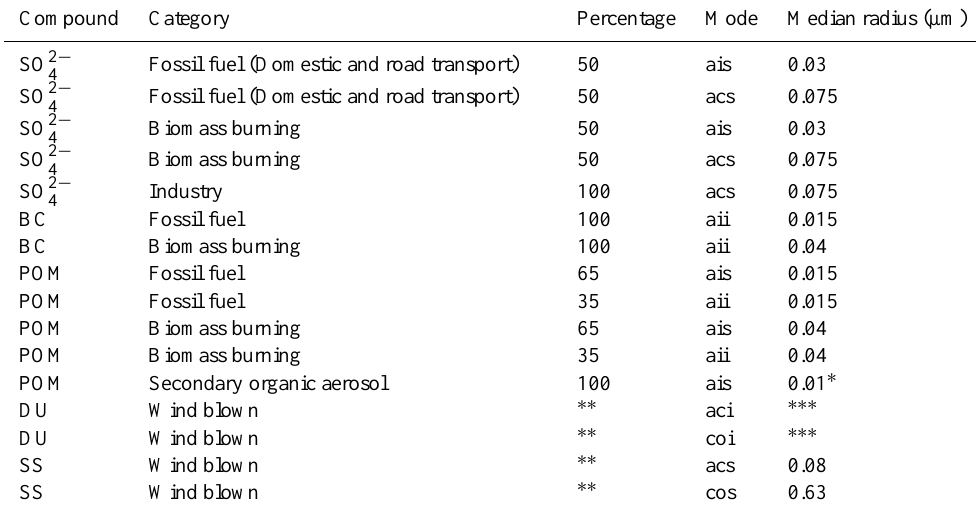
Table 2. Implemented aerosol emissions with the predefined M7 modes and median emission radii. Compound Category Percentage Mode Median radius (µm) SO 2 − Fossil fuel (Domestic and road transport) 50 ais 0.03 4 SO 2 − Fossil fuel (Domestic and road transport) 50 acs 0.075 4 SO 2 − Biomass burning 50 ais 0.03 4 SO 2 − Biomass burning 50 4